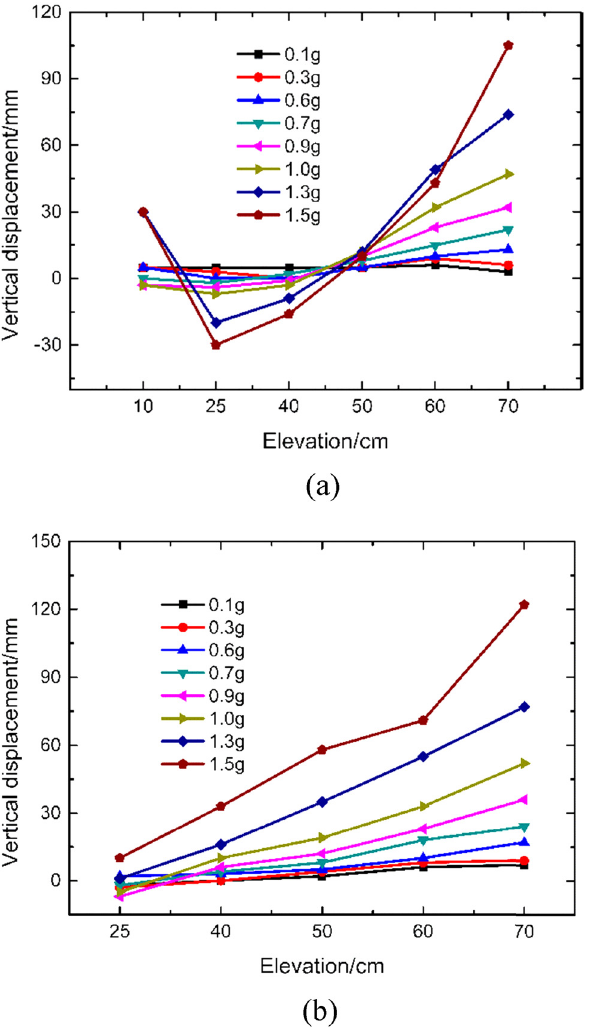
Figure 19: Vertical displacement of geotextile tubes against variable elevation: ( a ) side A and ( b ) side B.